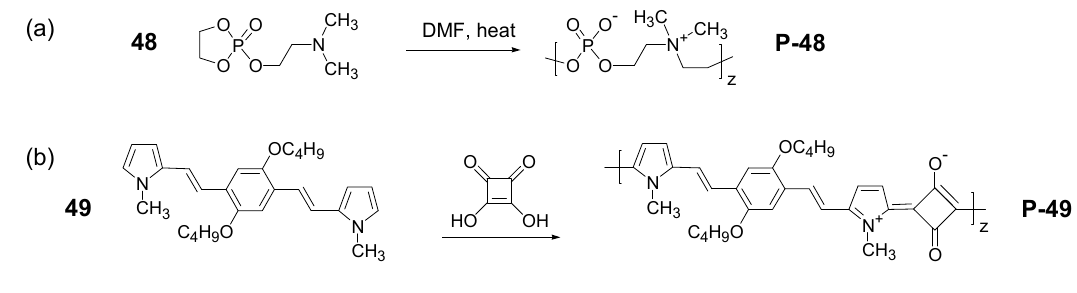
Figure 9. Examples for polyzwitterions produced via step growth polymerization, in which the zwitterionic moieties are created in situ : ( a ) Ionene type poly(phosphatidylcholine) [389]; ( b ) Polysquaraine